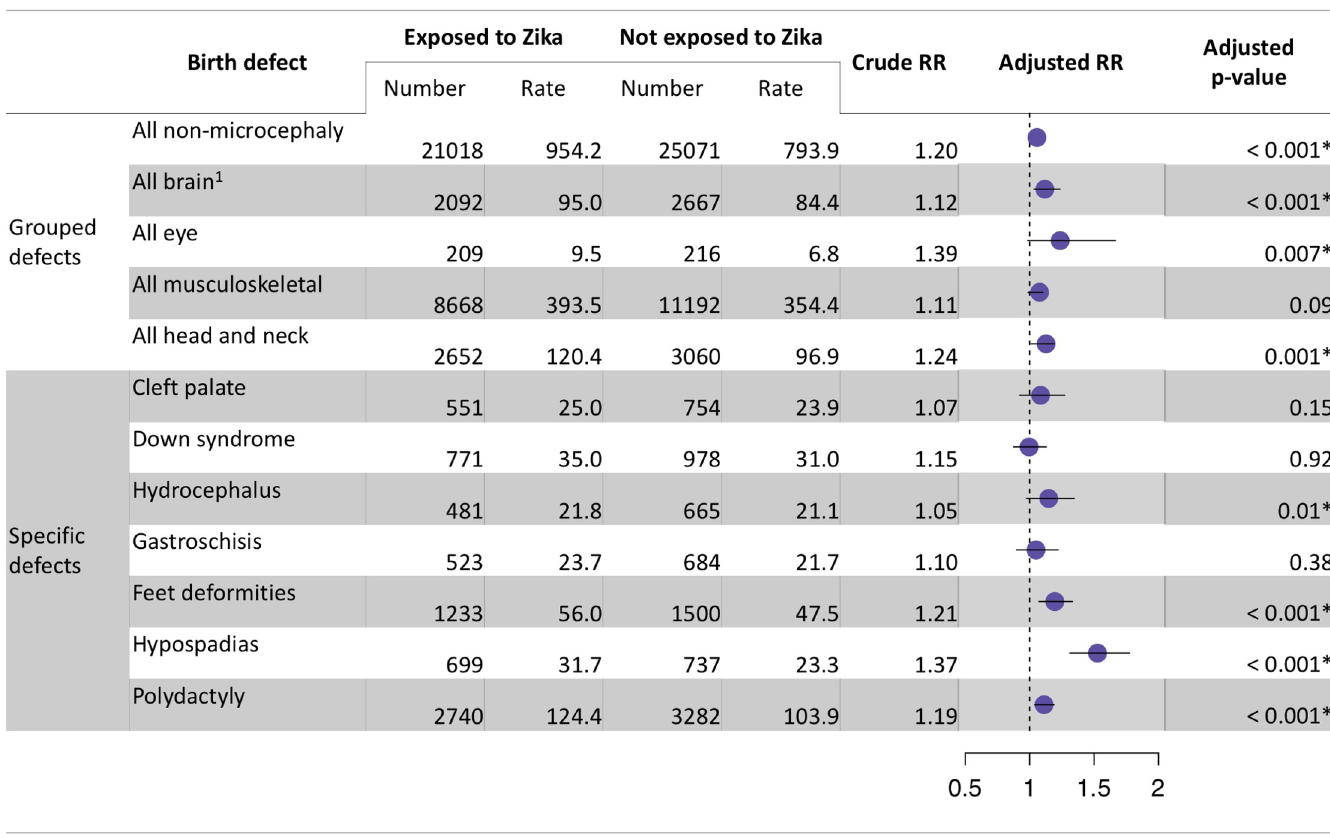
Mean predictions with 95% confidence intervals in parentheses are shown.